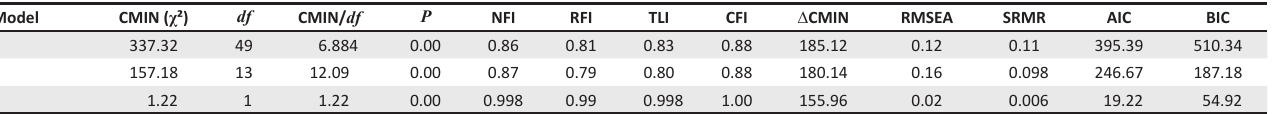
TABLE 5: Structural equation modelling results: Fit statistics ( N = 409). Model CMIN ( χ ²) df CMIN/ df P NFI BIC